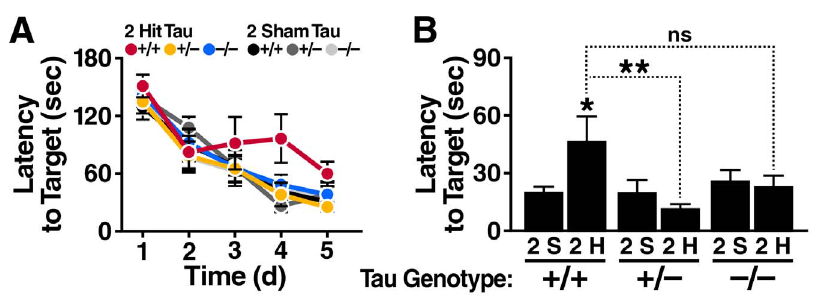
Fig. 6. Tau reduction diminishes learning and memory deficits caused by 2-hit frontal injury. Tau + / + , Tau + /– and Tau –/– mice (n 5 9–10 per genotype and treatment) received a 2-hit frontal impact injury or sham treatment, and were tested in the Barnes maze one month later. (A) Learning curves of the indicated groups. By linear mixed effects model analysis, injured Tau + / + mice differed from sham treated Tau + / + mice (p 5 0.0001), injured Tau + /– mice (p 5 0.02) and possibly also injured Tau –/– mice (p 5 0.09). Injured Tau + /– and Tau –/– mice did not differ from each other or from their respective sham treated controls. (B) Probe trial administered 24 h after the last training trial. Two-way ANOVA revealed a Tau genotype effect (p 5 0.016, F(2, 53) 5 4.54) and an interaction between Tau genotype and injury (p 5 0.011, F(2, 53) 5 4.95). *p , 0.05, **p , 0.01 vs. sham treated group of same genotype or as indicated by brackets (Tukey-Kramer test). ns, not significant; Sh, Sham. Data are means ¡ SEM.